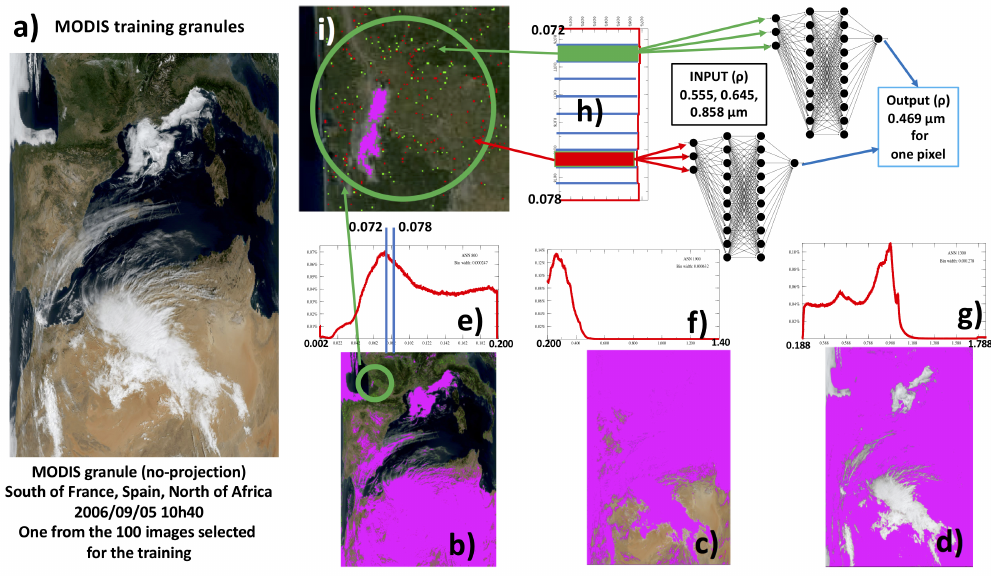
Figure 9. Scheme illustrating the pixel classification of the training ( a ) MODIS data. Subfigures ( b – d ) display the selected pixels (unselected pixels in magenta) sorted into classes (bins) by the ( e – g ) histograms. In histogram ( e ), we select 10 bins from 0.072 < x < 0.078 ( h ), and display the spatial location of two bins as green and red dots in the zoom ( i ). The MODIS reflectance values within a bin are used as inputs of the dedicated ANN (feedforward ANN with 3 inputs, 2 hidden layers with 10 nodes each, and 1 output) to retrieve the 0.469µm blue